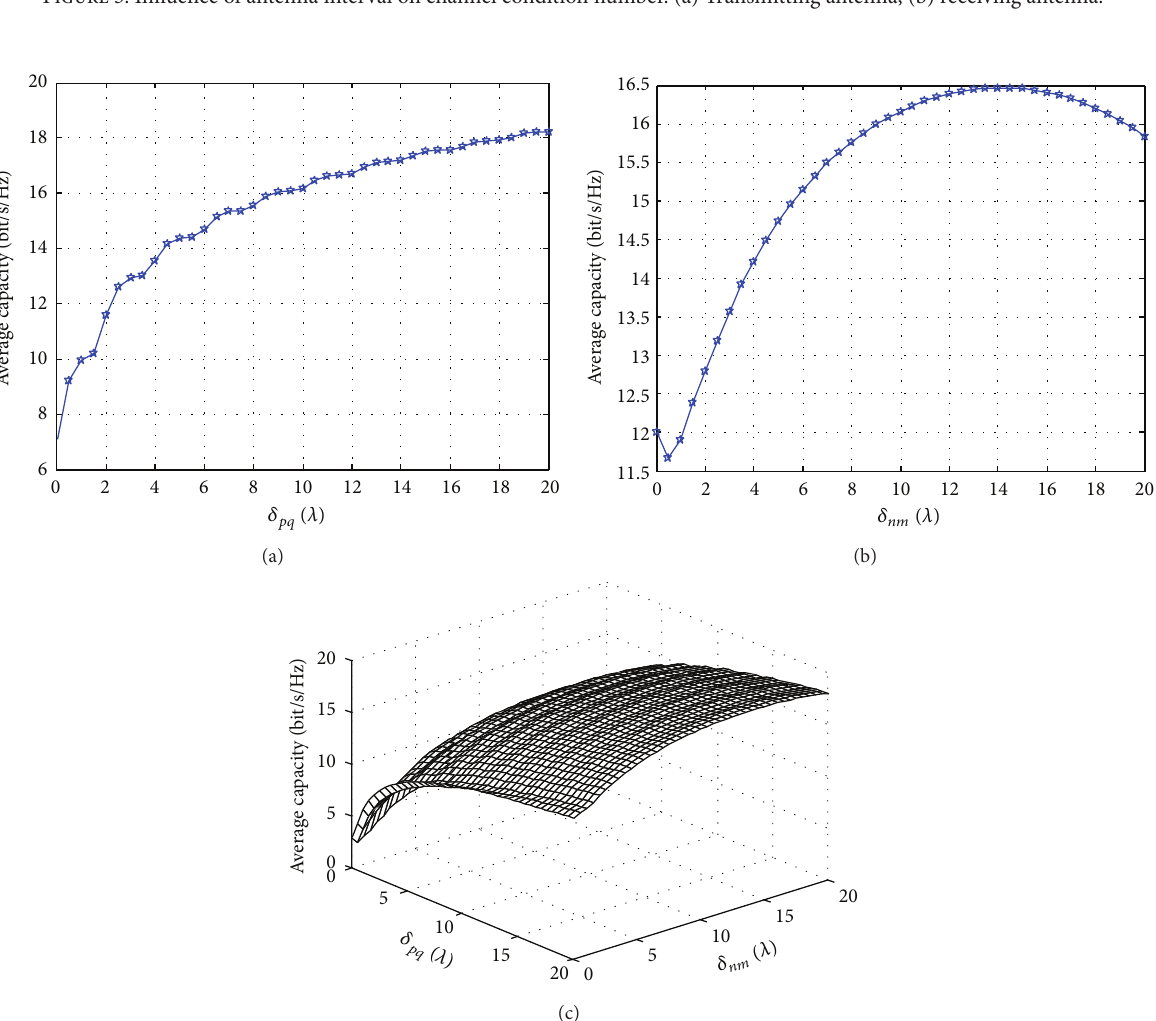
Figure 3: Influence of antenna interval on channel condition number. (a) Transmitting antenna; (b) receiving antenna.